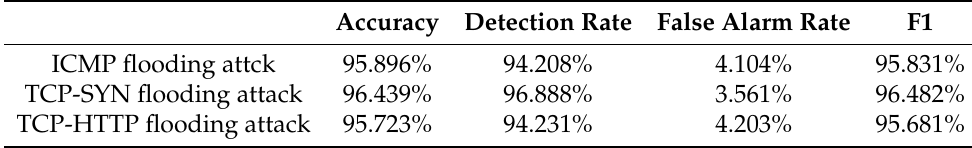
Table 7. Detection performance of the period detector in different kinds of EDoS